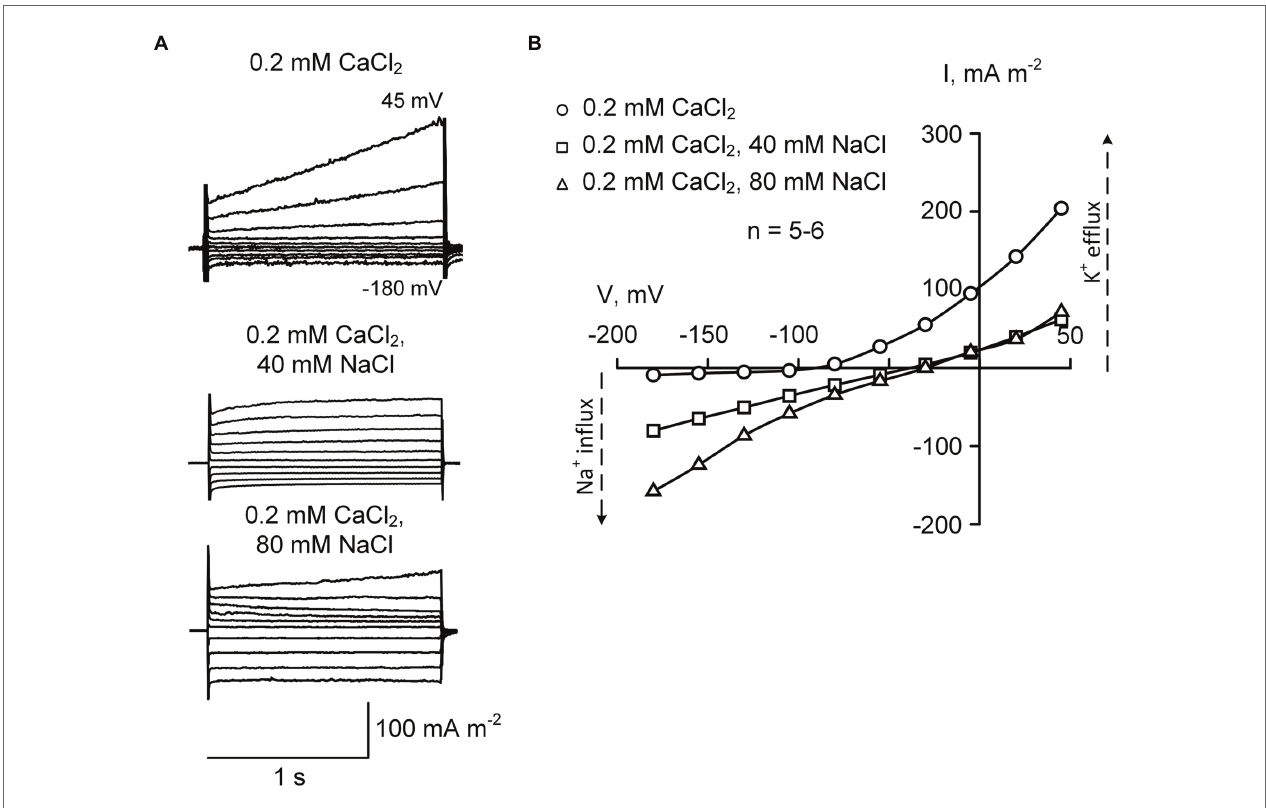
FIGURE 4 | Typical plasma membrane currents (A) and mean current-voltage curves (B) in H. annuus L. root protoplasts recorded in the presence of 0.2 mM CaCl 2 in the bathing solution at different levels of external NaCl (40 and 80 mM). Current-voltage curves were plotted by mean values ( n = 5–6; errors are not shown in the figure). The difference between “0.2 mM CaCl 2 ” (circles) and “40 mM NaCl” (squares) as well as between “0.2 mM CaCl 2 ” (circles) and “80 mM NaCl” (triangles) was statistically significant at all voltage values ( p < 0.01; ANOVA test). Statistically significant ( p < 0.01; ANOVA test) difference between “40 mM NaCl” (squares) and “80 mM NaCl” (triangles) was found at a voltage of more negative than − 80 mV. The standard bathing solution contained (in mM): 0.3 KCl, 2 Tris, adjusted to pH 6.0 with 1 MES, and 600 mOsM, with D-sorbitol. The pipette solution contained 70 mM K gluconate, 10 mM KCl; 100 nM Ca 2+ was adjusted with 1 mM BAPTA and 0.475 mM CaCl 2 , pH 7.2 with 2 mM Tris, 1 mM